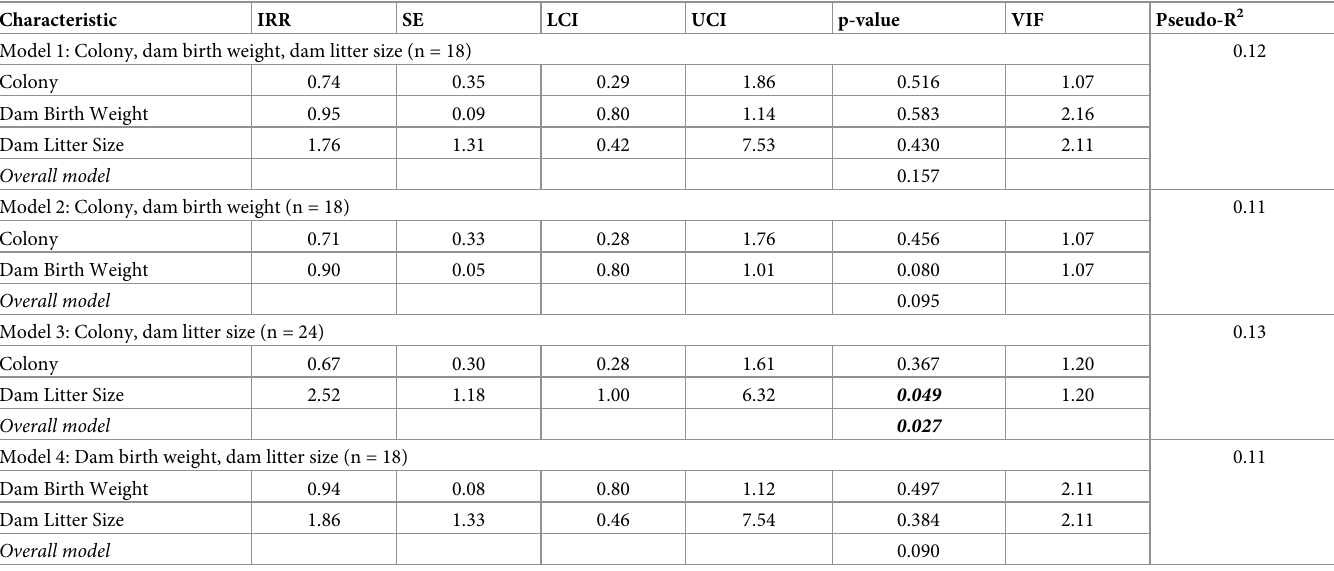
Table 4. Poisson multivariate regression models � predicting neonatal death �� .